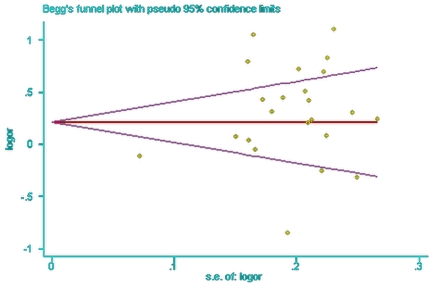
Begg’s funnel plot analysis for the comparison of the SNP+45 alleles.P value of Begg's test was 0.79 (continuity corrected).